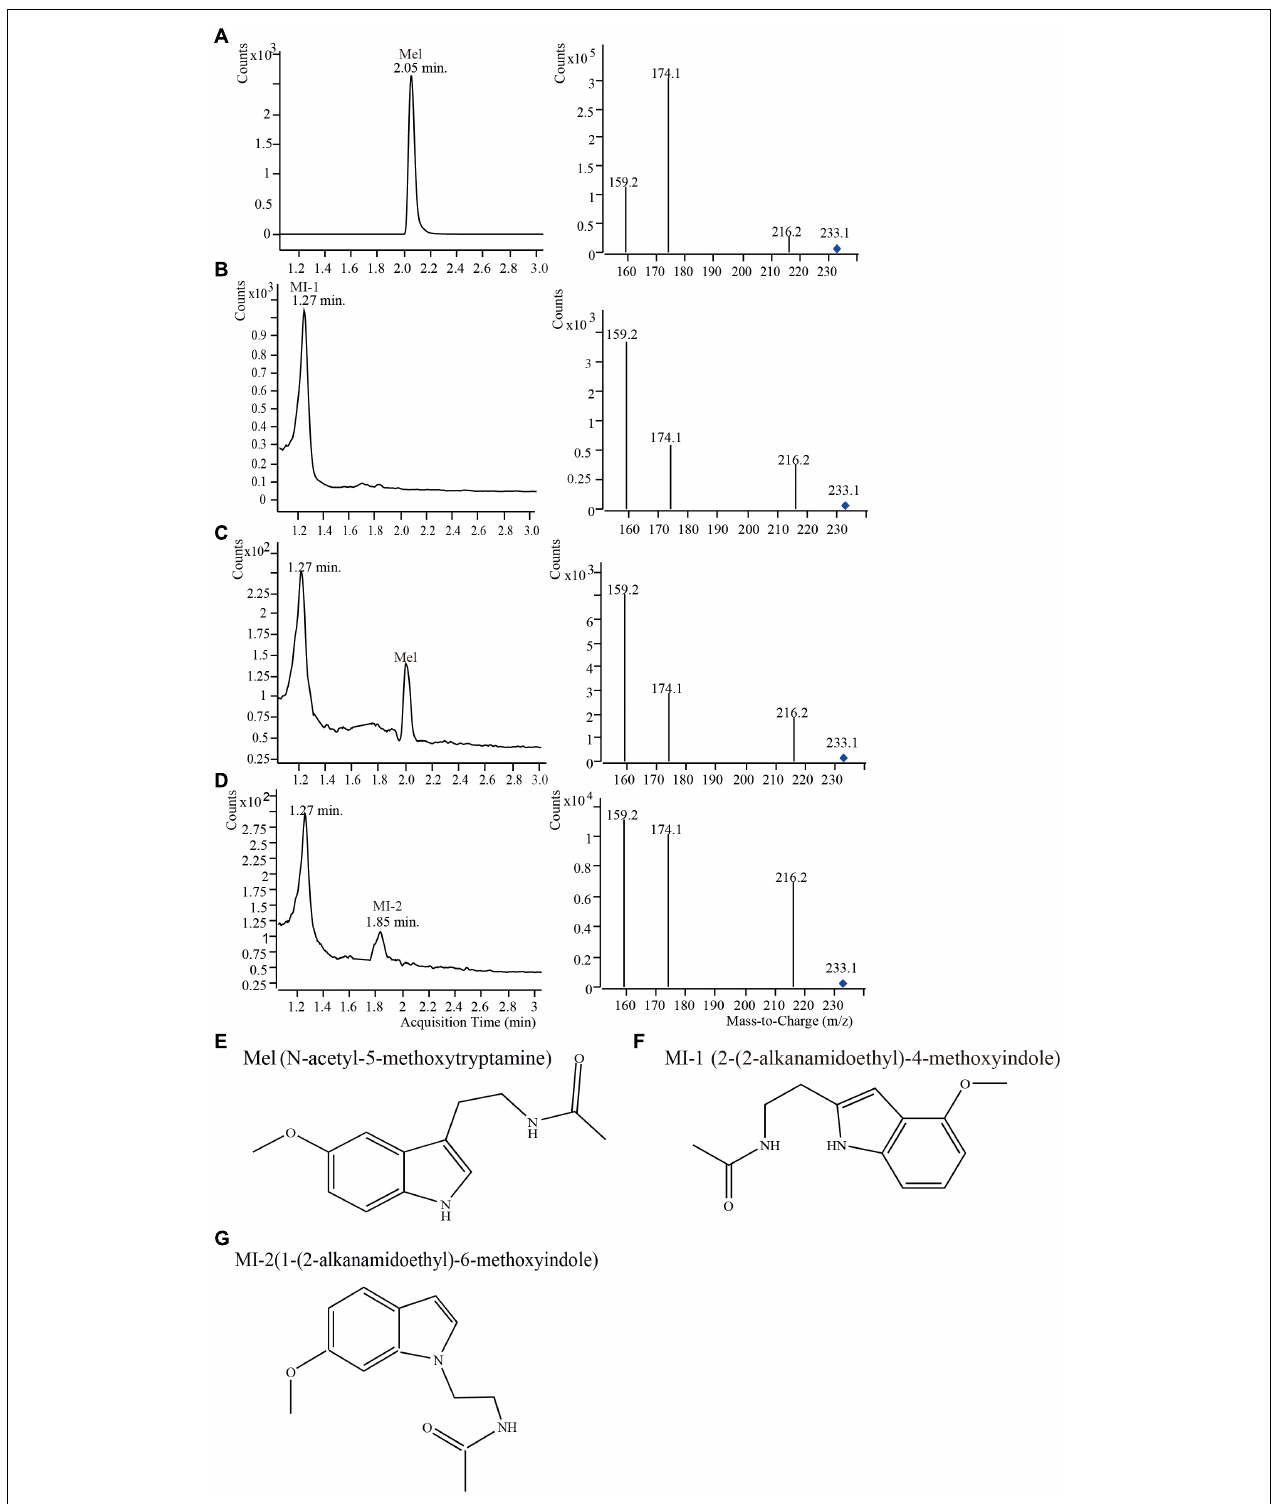
FIGURE 1 | Mass spectra of mulberry leaf samples from different varieties harvested in May, 2015 detected using UPLC-MS/MS, and the structural formulae of melatonin and its isomers. (A) Melatonin standard; (B) Sample S-36-L; (C) Sample S-4-L; (D) sample S-12-L; (E) melatonin; (F) 2-(2-alkanamidoethyl)-4-methoxyindole; (G) 1-(2-alkanamidoethyl)-6-methoxyindole.